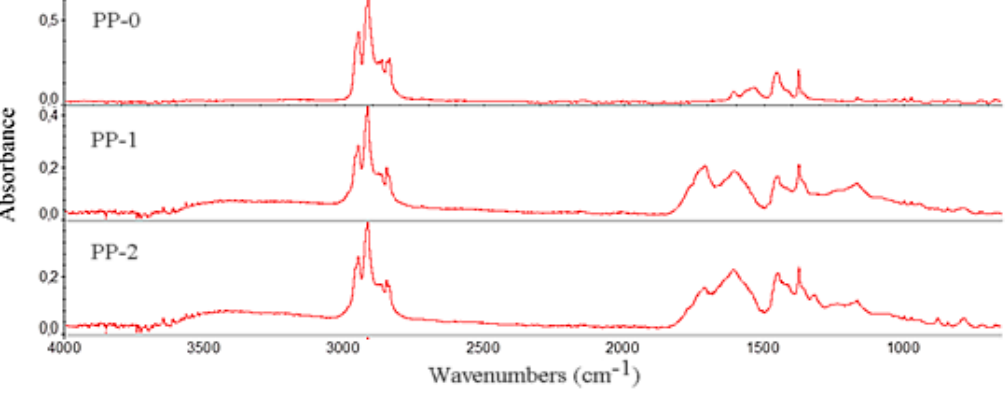
Figure 3. Fourier-transform infrared spectroscopy (FTIR) spectra of samples PP-0 to 2.